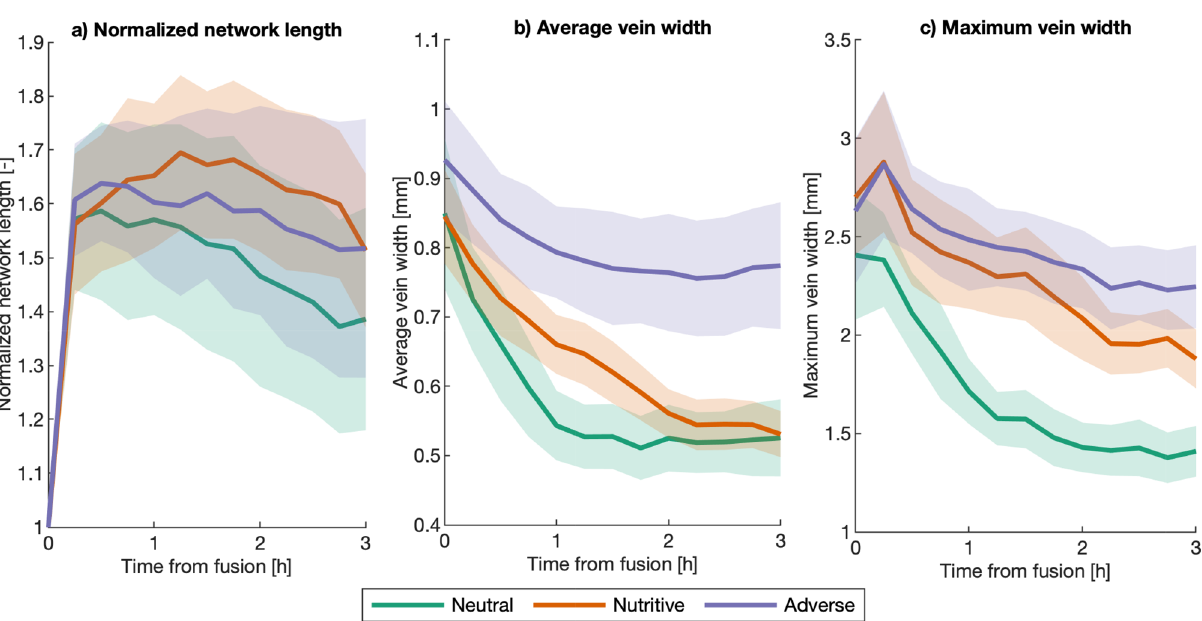
Figure 18. Network length and vein width inside FR ( a ) Network length inside normalized by the network length at fusion. ( b ) Average vein width inside FR. ( c ) Maximum vein width inside FR. Solid lines correspond to the mean value among replicates for the same substrate and shaded regions correspond to its confidence